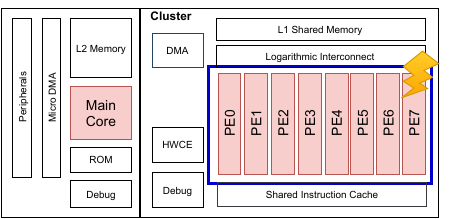
Figure 9. Overview of the GAP-8 architecture and RTL fault injection location. Table 2. Figures of variance when the chunks of neurons are assigned following static scheduling. Chunks Variance-Static